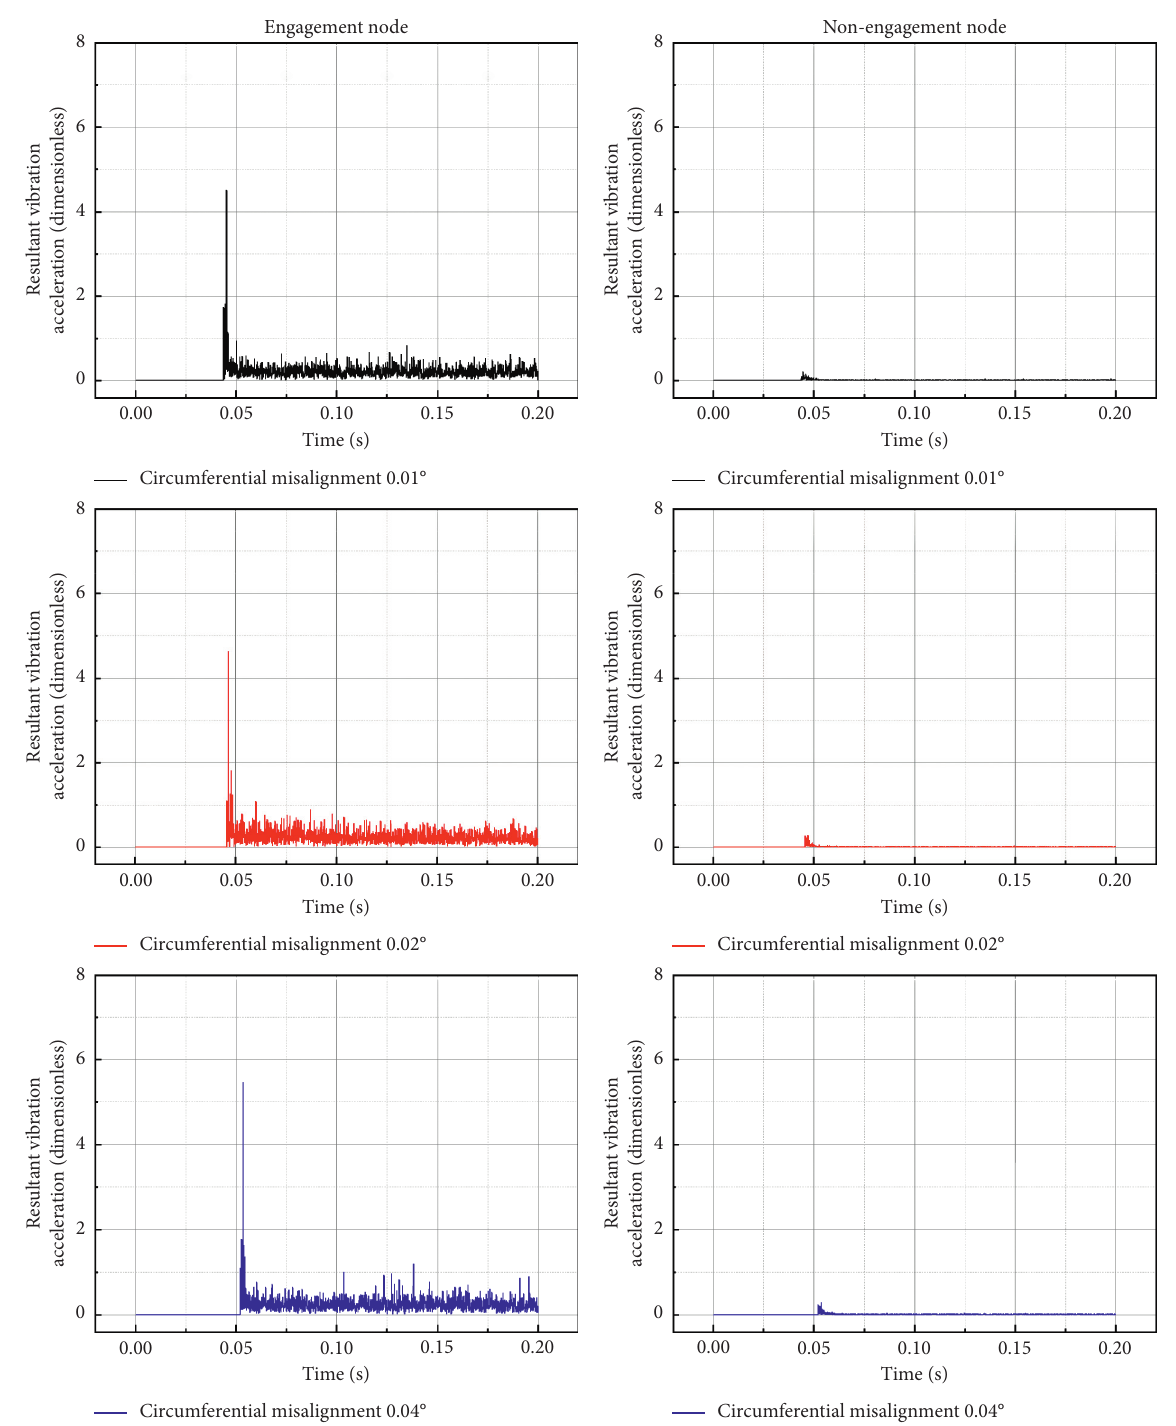
Figure 22: The comparison of resultant vibration of two categories nodes on axle spline with different circumferential misalignments φ under identical loading